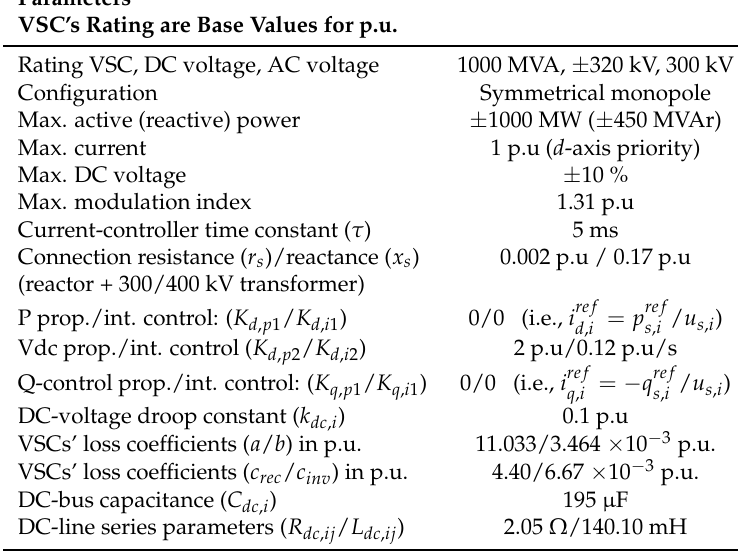
Table A3. Converter and HVDC grid